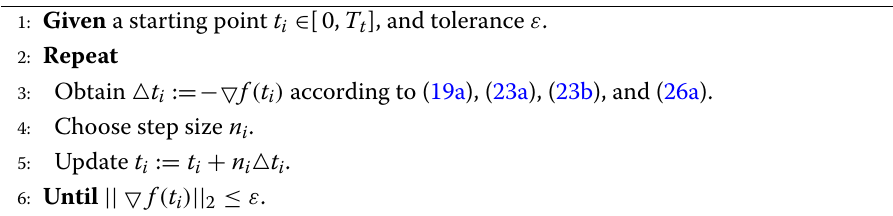
Algorithm 1 Gradient-descent